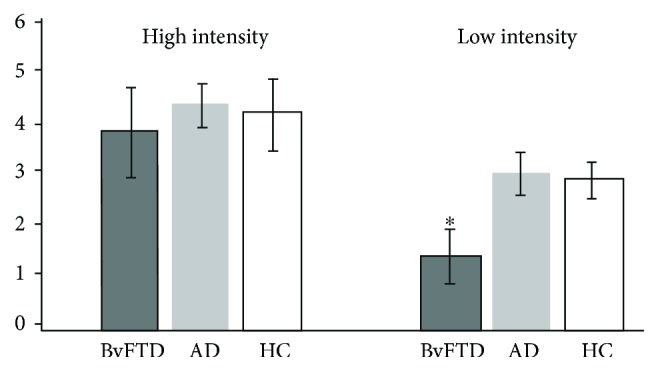
Group distress by level of vignette intensity among behavioral variant frontotemporal dementia (bvFTD), Alzheimer's disease (AD), and healthy control (HC) groups. The bvFTD group reported less distress (M = 1.40, SD = 1.05) than the other two groups when listening and viewing lower intensity vignettes (MAD = 3.01, SDAD = 0.95; MHC = 2.88, SDHC = 0.71). The groups reported no differences in the level of distress among higher intensity vignettes (MbvFTD = 3.81, SDbvFTD = 1.75; MAD = 4.34, SDAD = 0.95; MHC = 4.15, SDHC = 1.38). Asterisk indicates post hoc significance of the bvFTD group from the other groups.